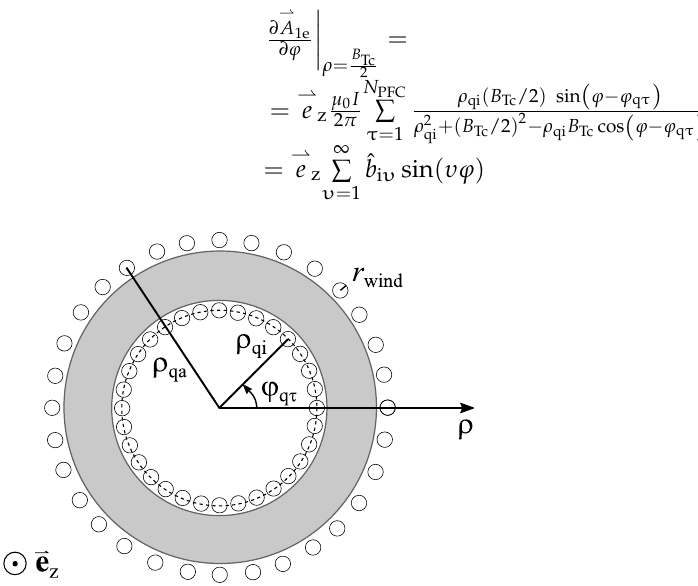
Figure 7. Arrangement of the windings around the toroidal core.